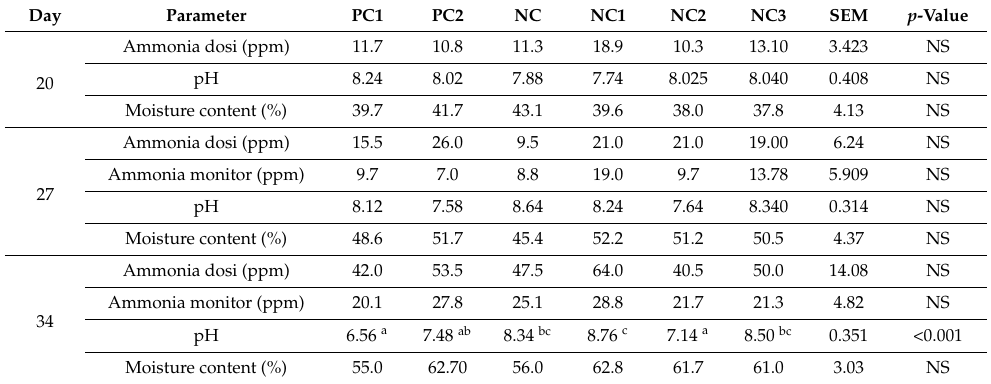
Table 5. The effect of the plant materials on the litter characteristics at different stages of production.